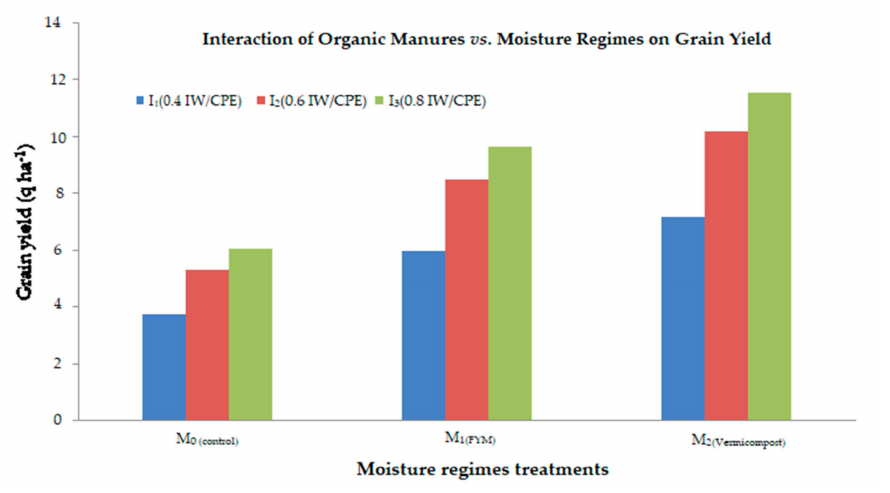
Figure 3. Interaction effect of organic manures and moisture regimes on grain yield (q ha − 1 ) of mustard crop.